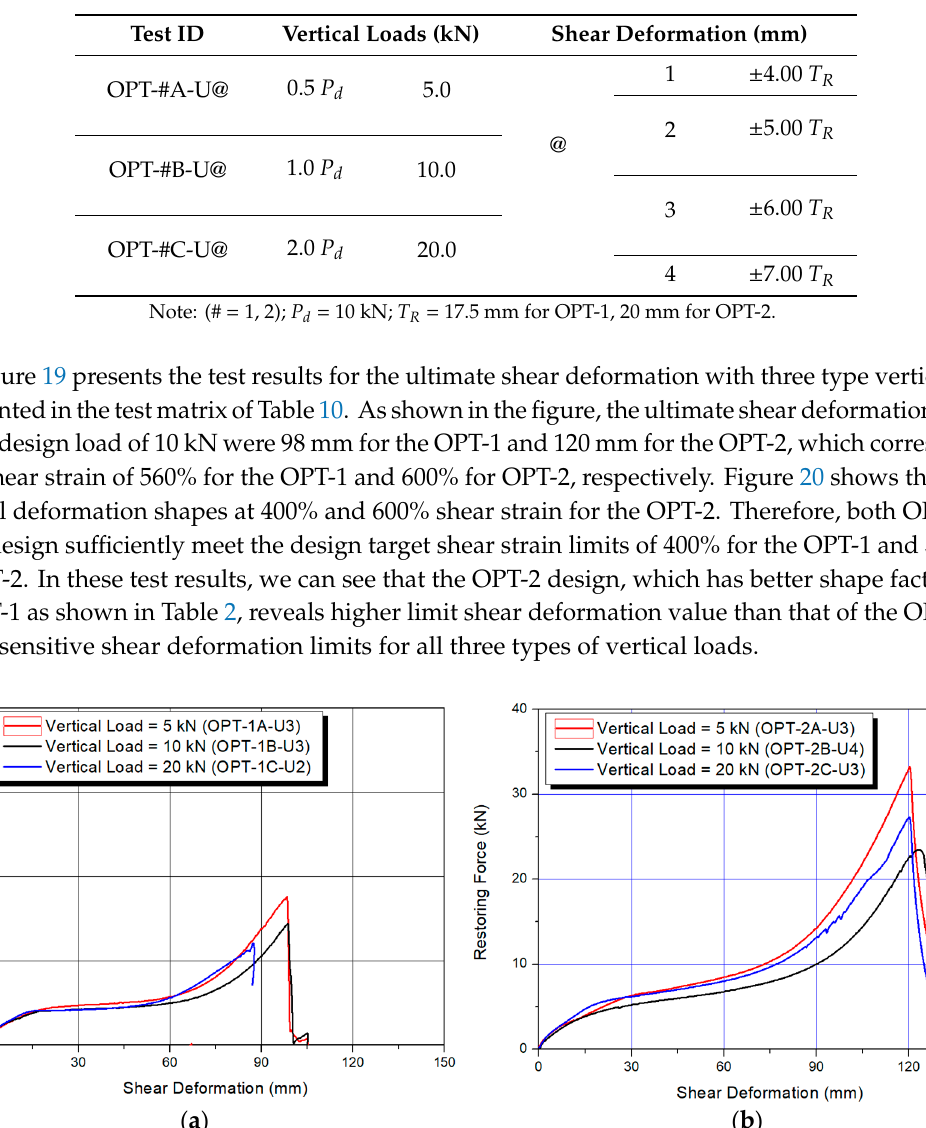
Table 10. Test matrix for ultimate shear deformation test.